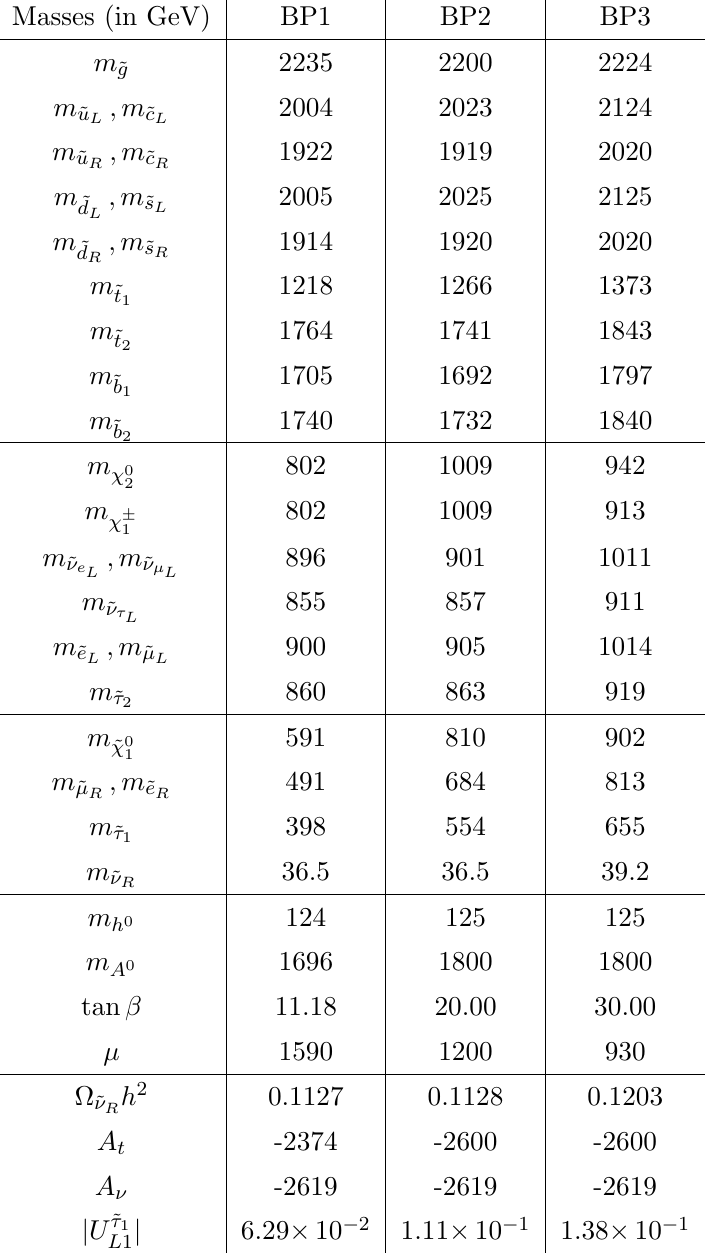
Table 2 . Benchmark points for studying the m